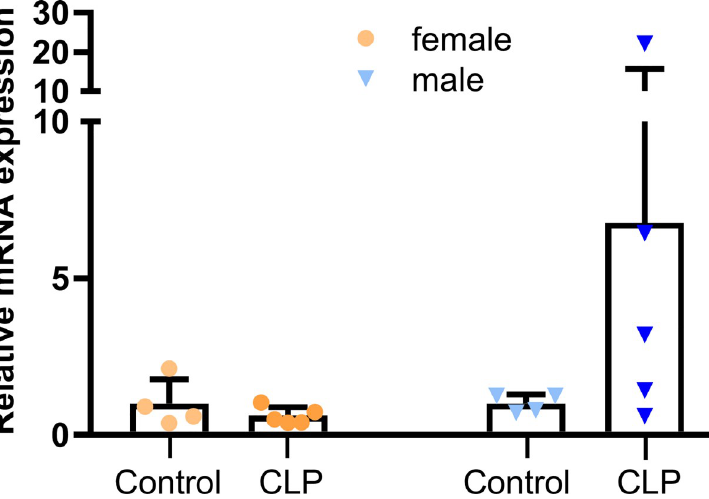
Fig 6. CLP-induced sepsis does not alter renal 1 α -hydroxylase mRNA expression. Relative renal mRNA expression of 1 α -hydroxylase measured by qRT-PCR in CLP mice (n = 5 female and male mice each) and healthy controls (n = 4 female and male mice each), 48 h post-surgery. Each bar represents the mean ± SD of 4–5 mice per experimental group. Each data point represents an individual